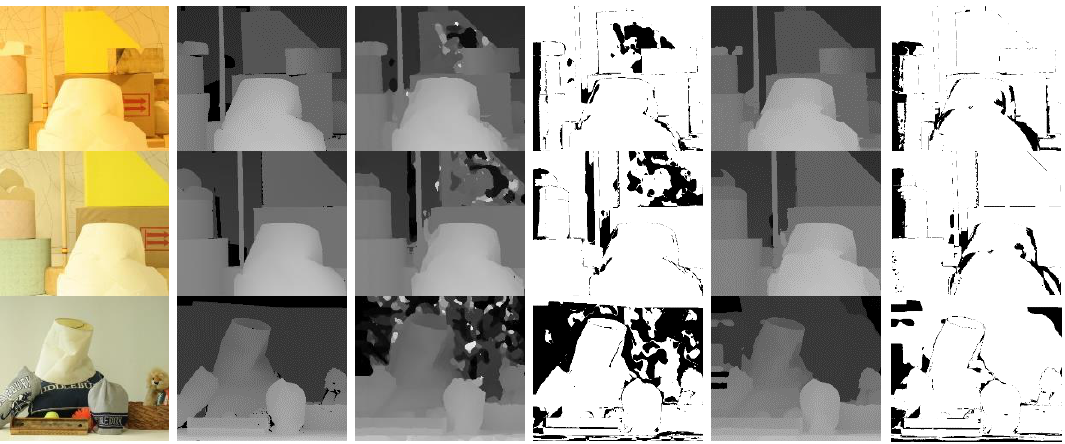
12 of 17 Table 4. Error matching rate of various cost computation without radiometric